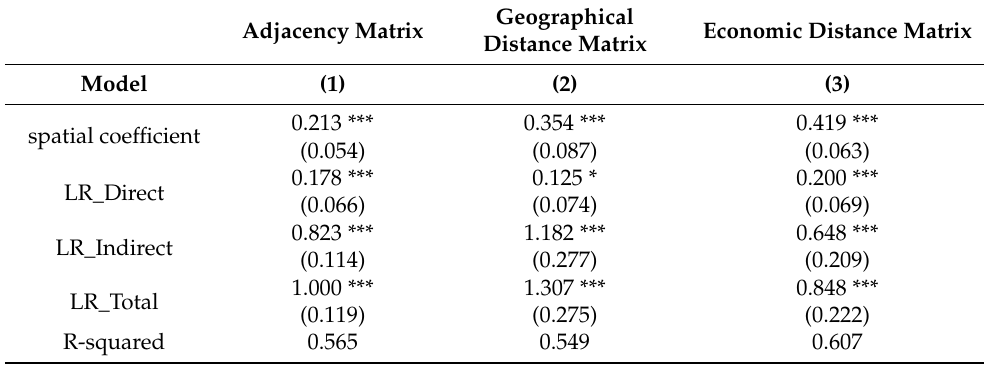
Table 4. Results of the spatial effect of mechanization on planting GTFP. Adjacency Matrix